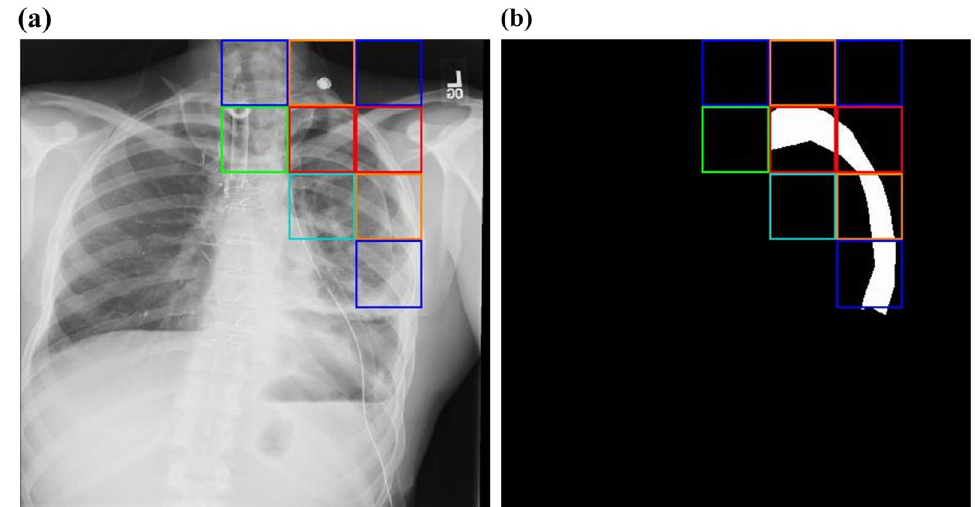
Figure 3. Example of well-predicted pneumothorax location. The location of pneumothorax predicted by a small artificial neural network is indicated by colored boxes. ( a ) Original chest X-ray image. ( b ) Image obtained after marking the location of pneumothorax in white and the remaining areas in